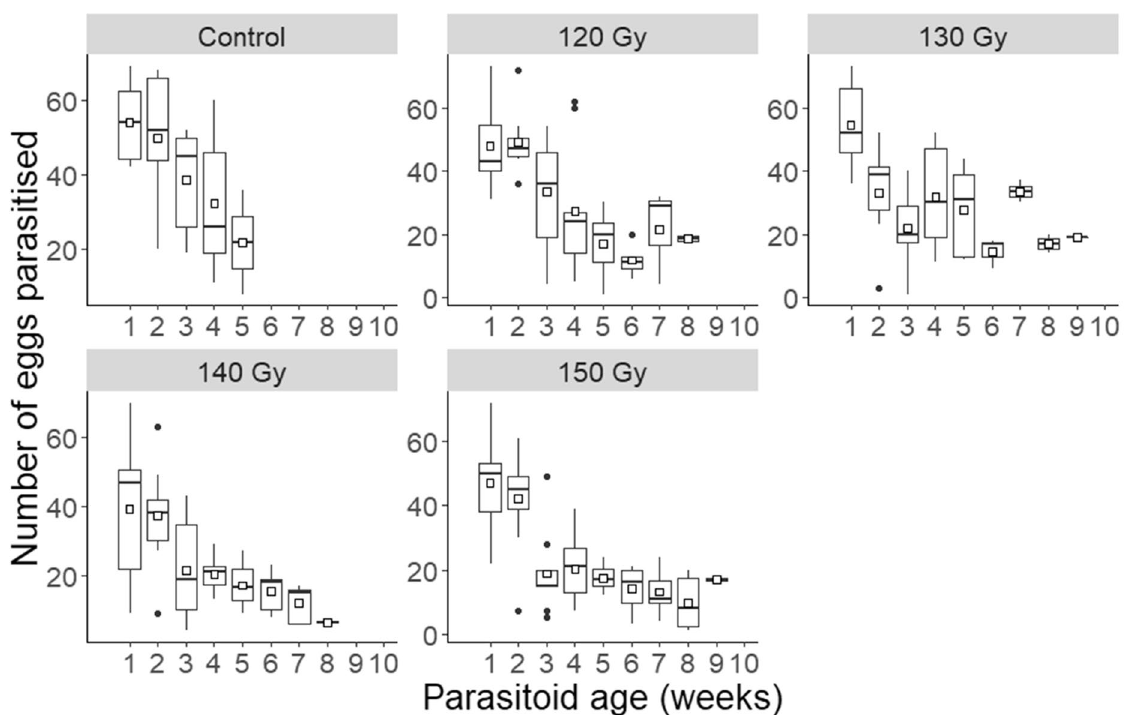
Figure 4. Boxplots of the number of Nezara viridula eggs parasitised by non-irradiated female Trissolcus basalis , and by those irradiated between 120–150 Gy, during each weekly host egg exposure. The box represents the interquartile range, and the whiskers are 1.5 times the interquartile range. Squares represent